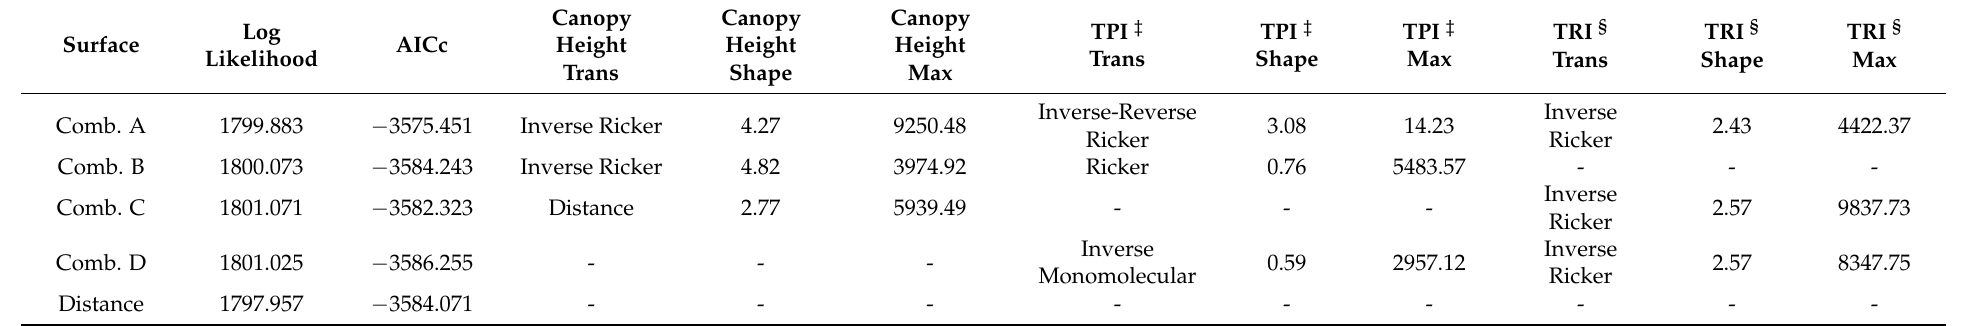
Table 5. Model results and resistance transformation variables, including the transformation equations, shapes, and maximum values for each continuous surface comprising the optimized composite surface. For each surface, the model was parameterized using log-likelihood, and AICc is presented for